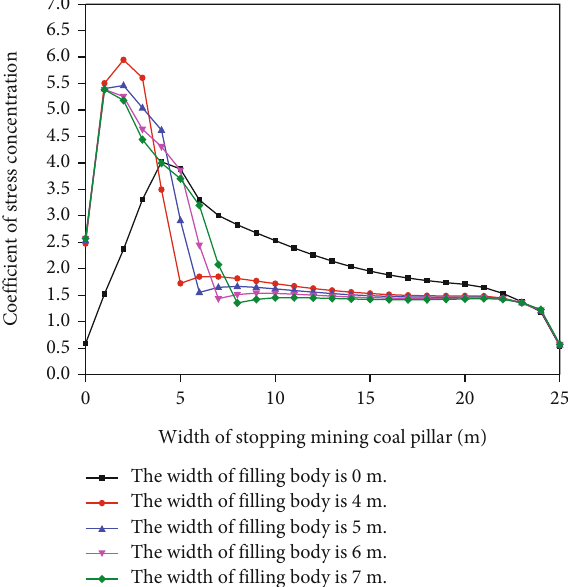
Figure 12: Curve of stress concentration coe ffi